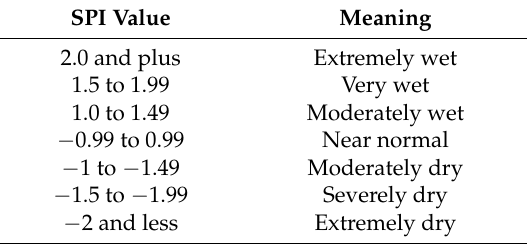
Table 2. Standardized precipitation index (SPI) values and their